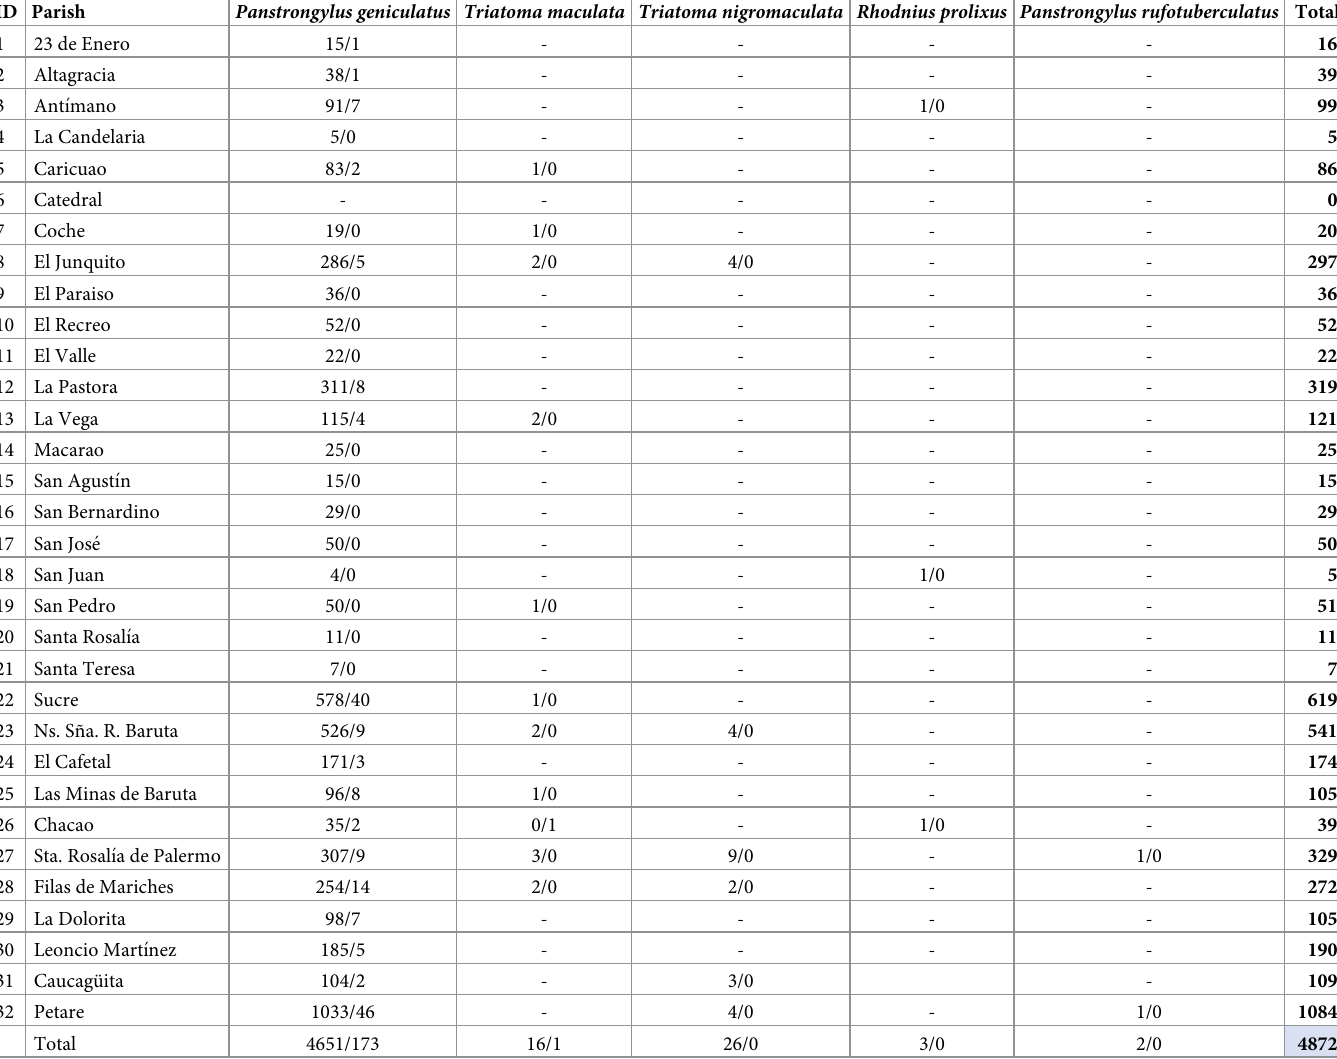
Table 1. Numbers of triatomine specimens obtained from each MDC parish for the collection period 2007–2019, tabulated by species. Slashes separate values for adult (left of slash) and nymphal triatomine specimens (right of slash). Hyphens (-) are used when no specimens of the indicated species were obtained from the parish. The IDs used for parishes correspond to those used in Fig